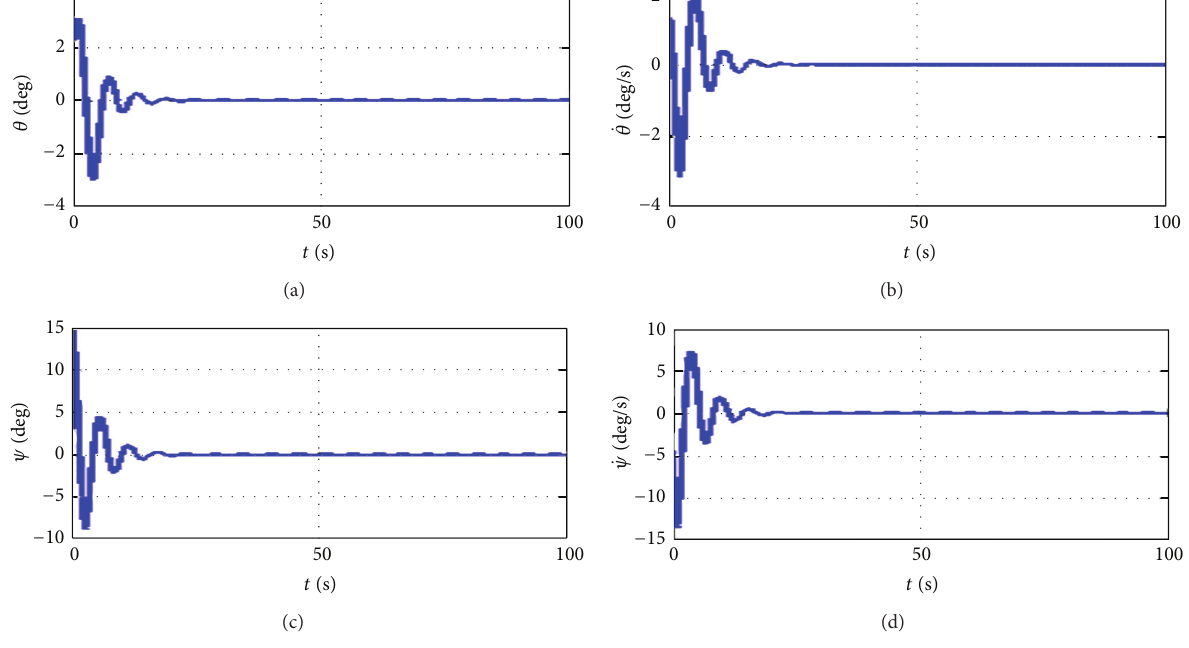
Figure 2: Performance of the LQR control law.